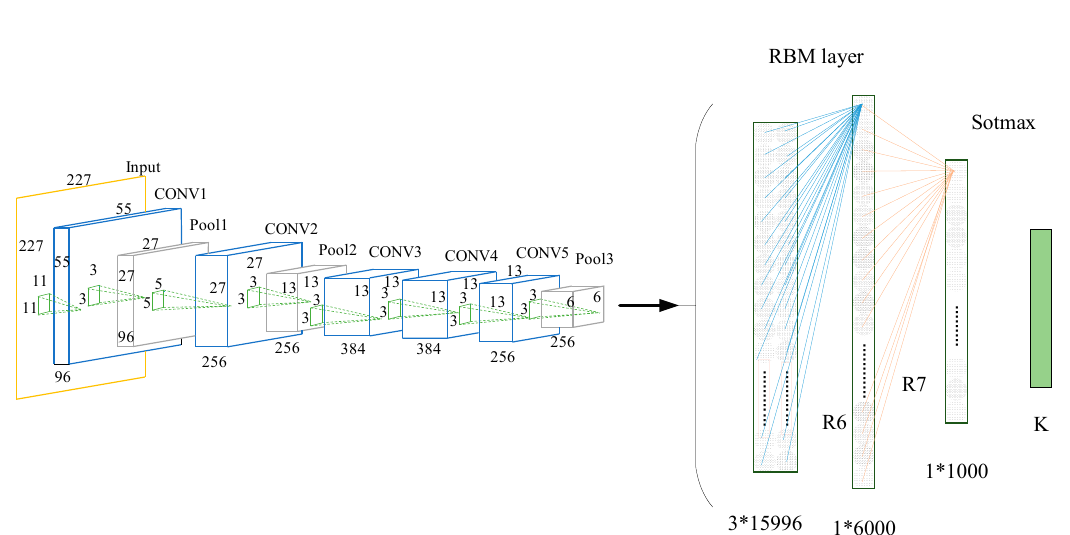
Figure 5. Structure of the TLCNN-RBM hybrid model.